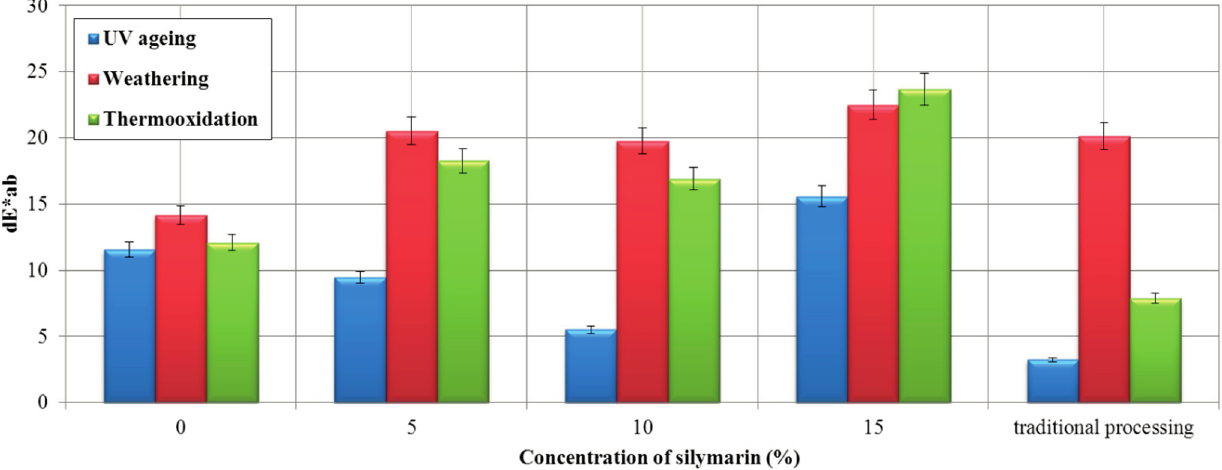
Figure 8. Effect of silymarin on the color of EPM material. The b index (the yellow/blue coordinate, with + b * indicating yellow and − b * indicating blue) tested in the CIE-Lab coordinate space.